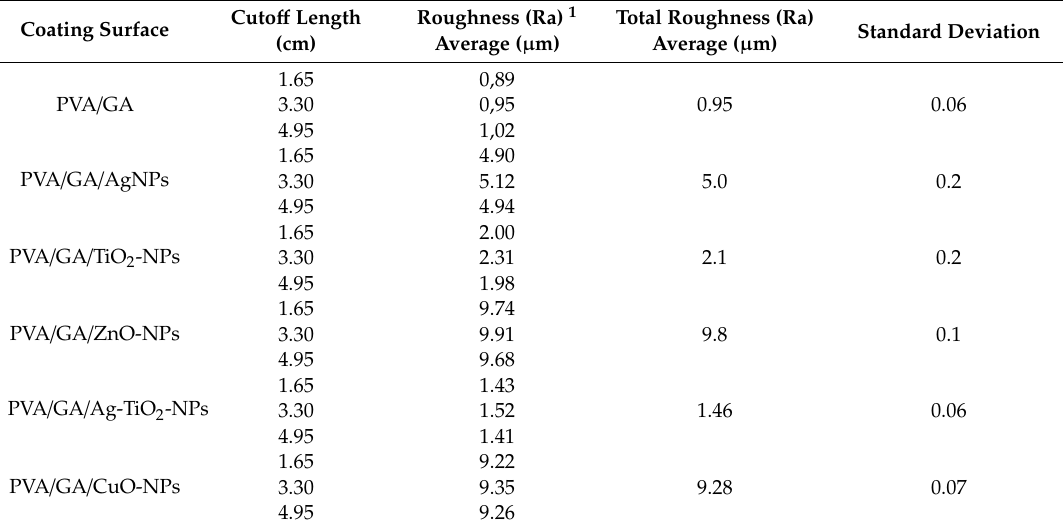
Table 3. Roughness test results for the di ff erent coatings applied to the substrate.